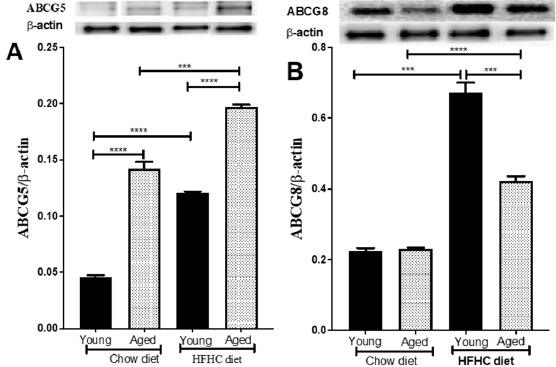
Figure 5. An HFHC diet upregulates ABCG5/ABCG8 protein expression by hepatic cells. Young and aged mice were fed chow or an HFHC diet for 12 weeks. They were then euthanized and ( A ) ABCG5 and ( B ) ABCG8 protein levels were measured in their livers by Western blotting. Data are expressed as means ± SEM. *** p < 0.0003 , **** p < 0.0001 versus chow. Cholesterol was eliminated from the liver into the bile either as cholesterol or as bile acids. Cholesterol was converted to 7-alpha-hydroxycholesterol by the cytochrome P450 7A1 (CYP7A1) enzyme, which was the first and rate-limiting step in bile acid synthesis. We, thus, investigated the age-related and diet-related expression levels of CYP7A1. Our results showed that CYP7A1 was equally expressed in both young and aged mice. (Figure 6). The HFHC diet induced an increase in the expression of CYP7A1 in both the young and old mice, albeit to a lower extent in the aged mice, but was not statistically significant (187%, p < 0.0001 versus 183%, p < 0.0001, respectively).